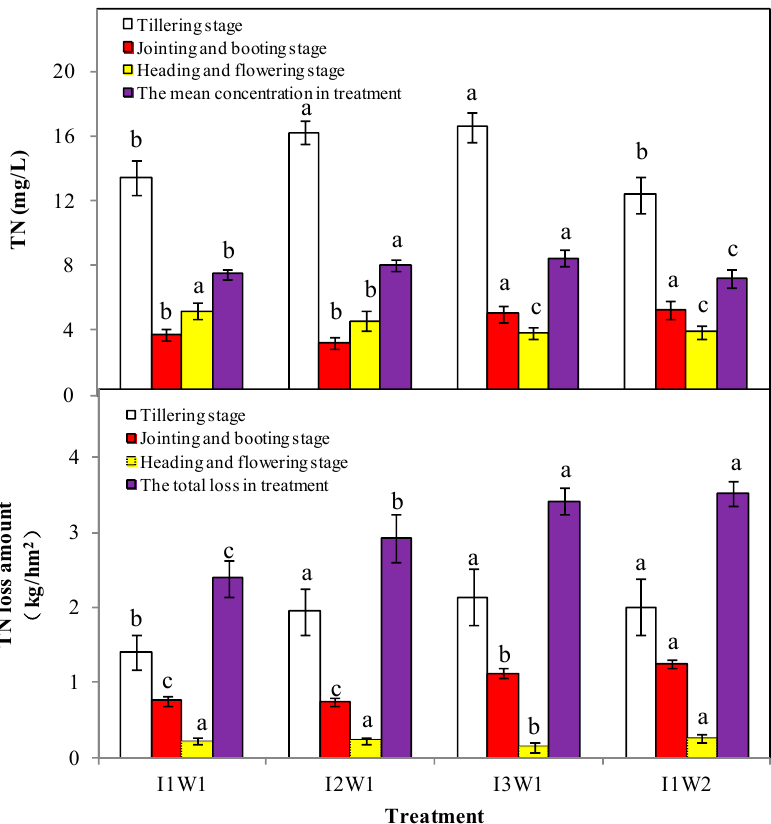
Figure 4. TN losses for ground water discharge in different irrigation treatments. TN means total nitrogen. I1W1 represents shallow–frequent irrigation with aquaculture wastewater; I2W1 represents shallow–wet irrigation with aquaculture wastewater; I3W1 represents flooding irrigation with aquaculture wastewater; I1W2 represents shallow–frequent irrigation with fresh water. Data are mean ± SD ( n = 4). The different letters on the tops of columns indicate significant differences among treatments at 5% according to Duncan’s multiple range test.